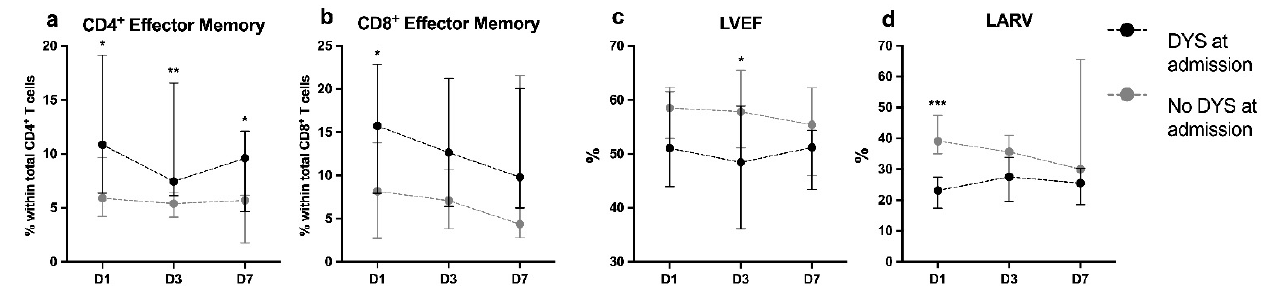
Figure 3. Median percentages with IQR of: ( a ) CD4 + effector memory T cells; ( b ) CD8 + effector memory T cells; ( c ) left ventricle Eeection fraction; and ( d ) left atrium reservoir strain at admission (D1); at 2nd to 3rd day (D3); and at 7th to 10th day (D7); Black and grey circles indicate groups of patients with (DYS) or without (nDYS) cardiac dysfunction at admission, respectively. Differences between DYS and nDYS groups at each timepoint were analyzed with the Mann–Whitney test. * p -value < 0.05; ** p -value < 0.01; or *** p -value < 0.001.